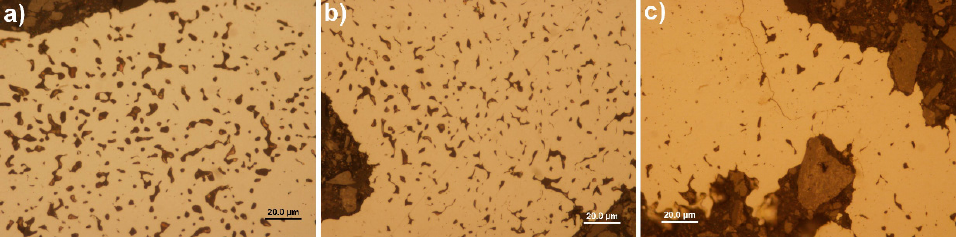
Figure 2. Microstructure of open cell iron samples with increasing amounts of PEG coating: Fe-PEG1, 0.8 wt. % PEG ( a ); Fe-PEG2, 1.5 wt. % PEG ( b ); Fe-PEG3, 3.0 wt. % PEG ( c ).